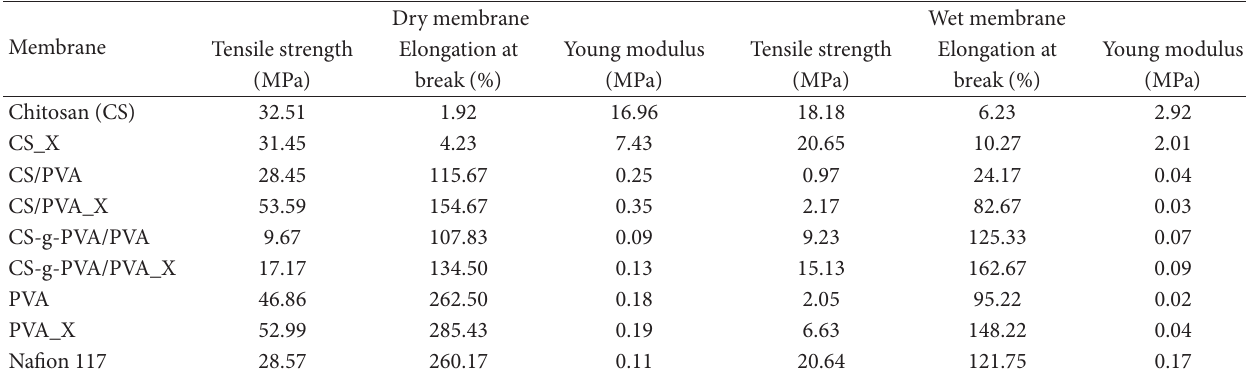
T 3: Mechanical properties of dry and wet membranes at room temperature.